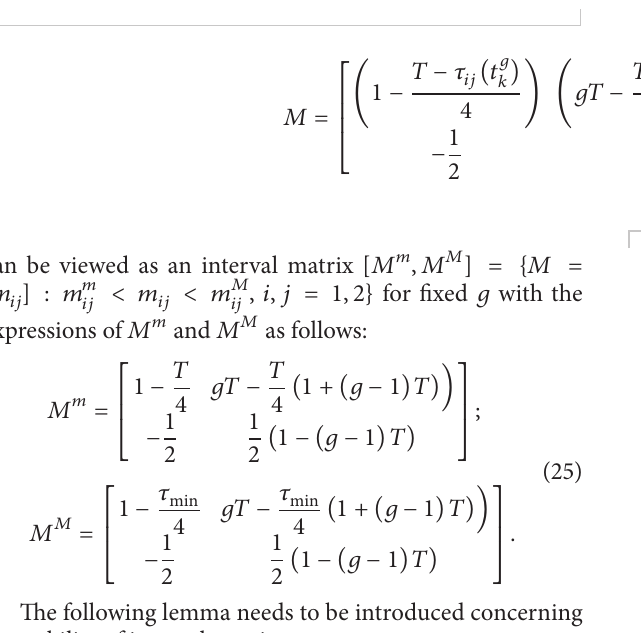
dash line circle can be presented as (23). The agents in the